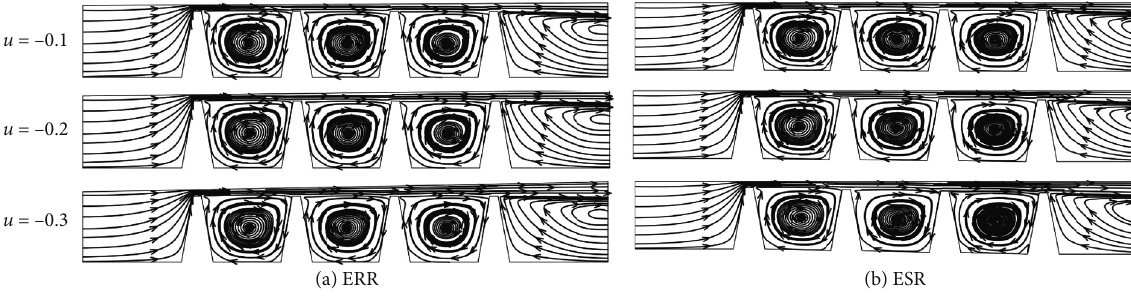
Figure 8: Flow structure in the labyrinth seal ( Re = 10000 , π = 1 : 3 , M